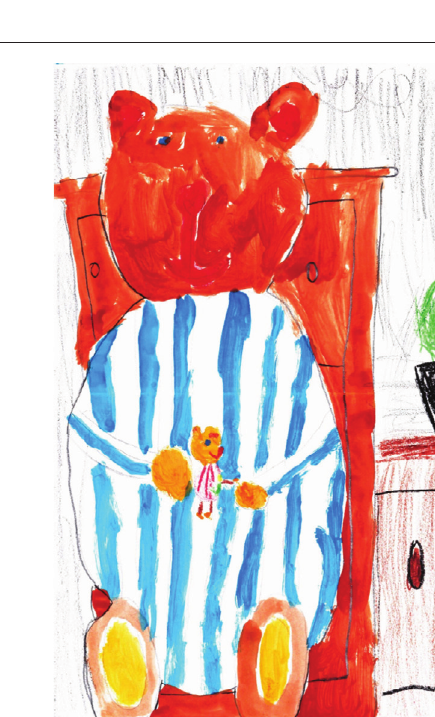
Figure 3: Post-screening activities to characterize Paddington